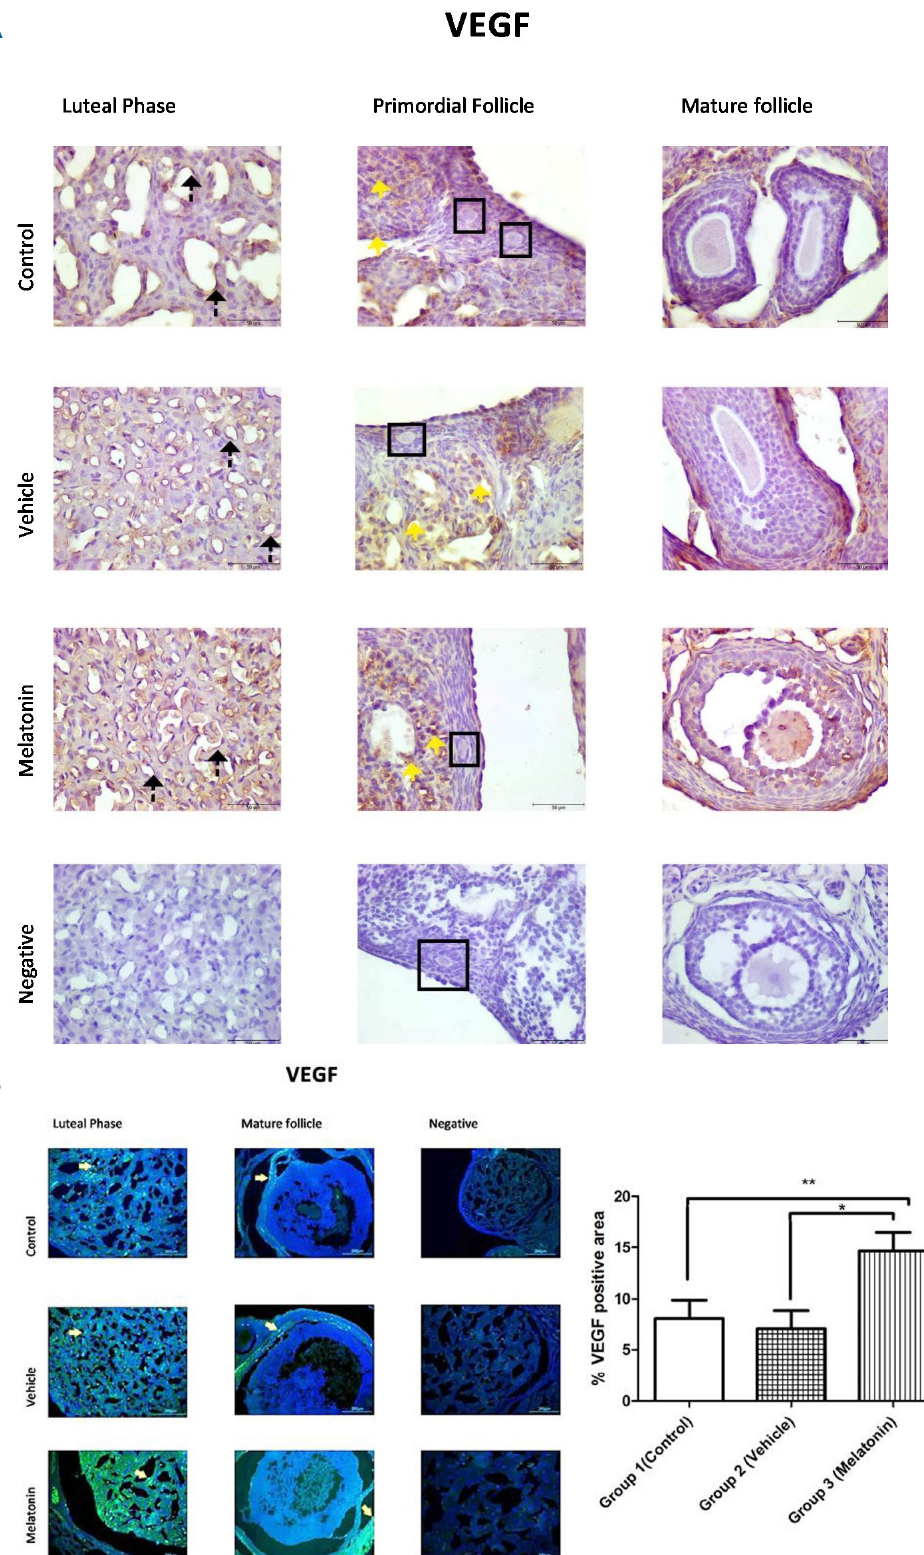
A: Immunohistochemical staining, B: Immunofluorescence staining Immunoreactivity of VEGF proteins in Group 1 (control), Group 2 (vehicle), and Group 3 (melatonin). An increase in VEGF in the endothelial cells of the blood vessel (as indicated by yellow arrows) can be seen in the melatonin treatment group. Data are displayed as the mean ± S.E.M.; n=15 rats/group. **, p <0.05 indicates significance compared to the respective control values. *, p <0.05 indicates significance compared to the respective vehicle values. Figure 3 - Immunoreactivity of VEGF